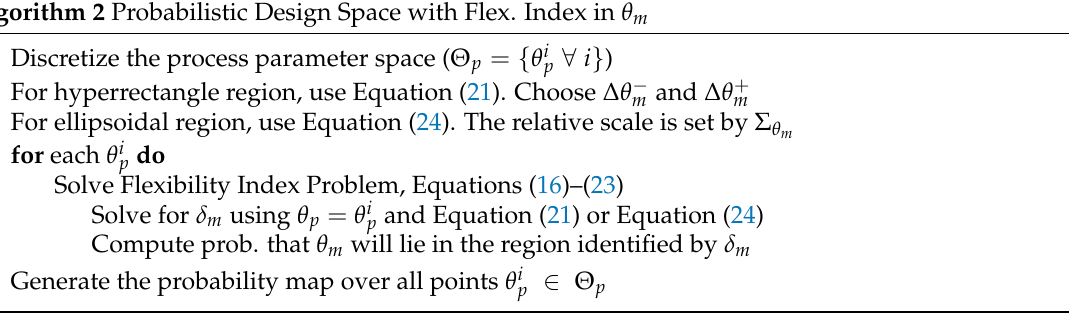
Algorithm 2 Probabilistic Design Space with Flex. Index in θ